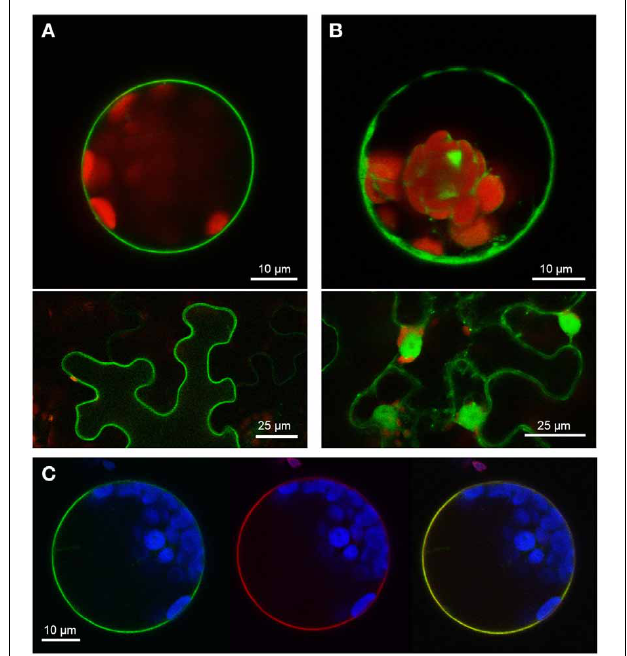
FIGURE 4 | Localization of SAUL-type PUB-ARM proteins from Populus trichocarpa at the plasma membrane. (A) Confocal analysis of fluorescence of Arabidopsis leaf protoplasts (top panel) and tobacco leaf epidermal cells (bottom panel) expressing GFP-Pt0005s27480 fusion proteins. GFP fluorescence depicted in green was detected at the plasma membrane in both cell types. Chlorophyll auto-fluorescence within the chloroplasts is depicted in red. (B) Confocal analysis of fluorescence of Arabidopsis leaf protoplasts (top panel) and tobacco leaf epidermal cells (bottom panel) expressing GFP-Pt0004s02840 fusion proteins. GFP fluorescence depicted in green was detected in cytosol and nucleus in both cell types. Chlorophyll auto-fluorescence within the chloroplasts is depicted in red. (C) Localization of GFP-Pt0005s27480 fusion proteins at the plasma membrane of Arabidopsis protoplasts. Confocal laser scanning microscopy detected fluorescence of GFP-Pt0005s27480 proteins depicted in green (left) and RFP-UmSrt1 (middle) proteins depicted in red at the plasma membrane of protoplasts co-expressing GFP-Pt0005s27480 and RFP-UmSrt1. Merging both images resulted in yellow signals (right) derived from the overlap of green (GFP-Pt0005s27480) and red (RFP-UmSrt1) fluorescences. Chlorophyll auto-fluorescence within the chloroplasts is depicted in